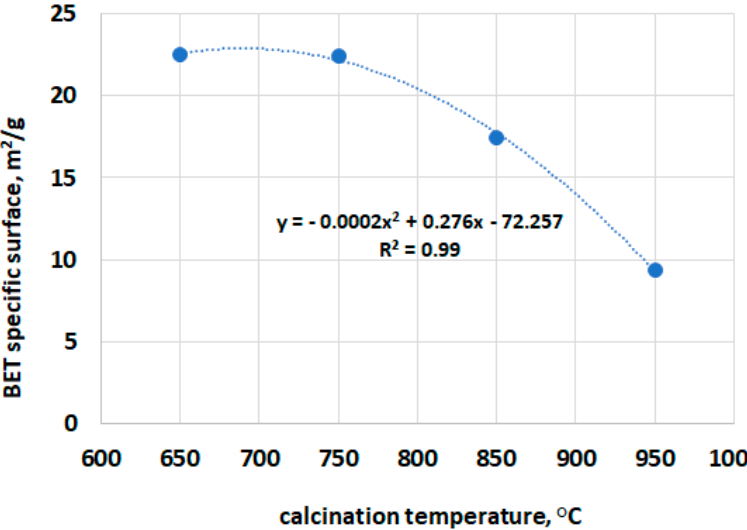
Figure 2. Relationship between SSA of the calcined clay determined by BET method vs. calcination temperature.